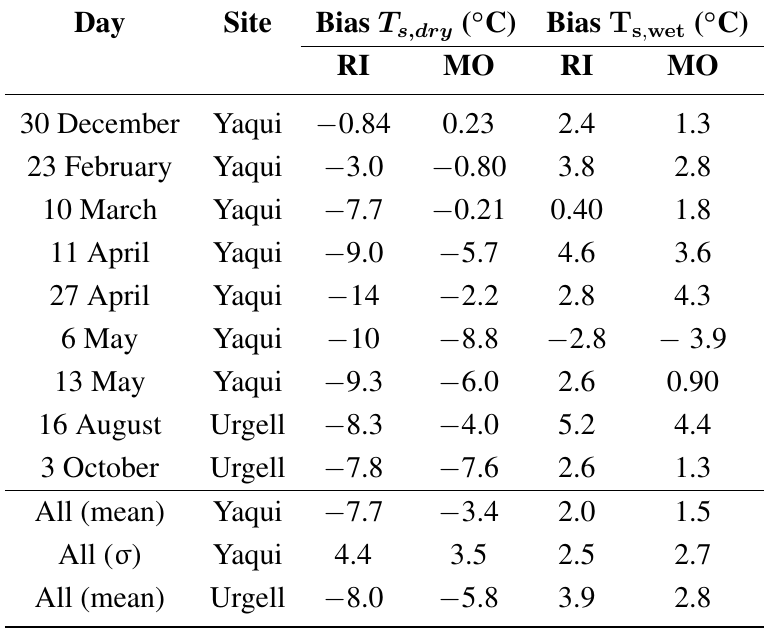
Table 2. Difference between the soil Tends simulated by EBsoil with the RI and MO aerodynamic resistance and the soil Tends retrieved from 90-m resolution data for the minimum and maximum soil Tends, for the Yaqui and Urgell regions